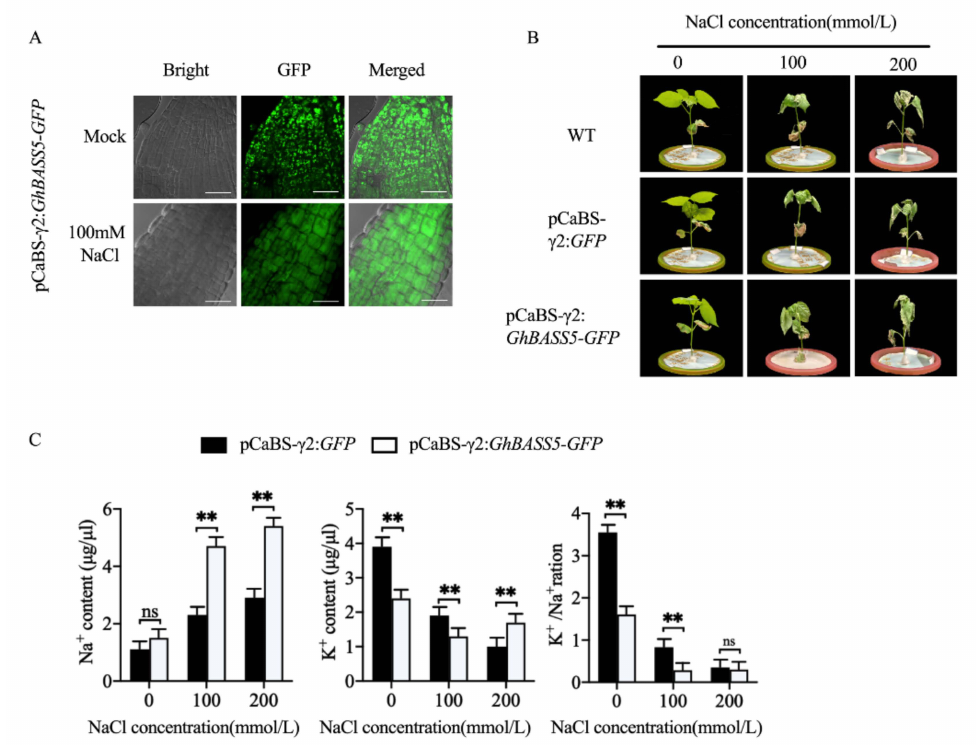
Figure 4. The characterization of GhBASS5 in the salt tolerance using the BSMV system. ( A ) Fluores- cence signal of GhBASS5-GFP in cotton root cells under simulated and salt stress; ( B ) phenotypes of the WT, GFP, and GhBASS5-GFP plants under simulated and salt stress; ( C ) Na + and K + contents in GFP plants and GhBASS5-GFP plants obtained via viral solution immersion under 100 mM salt treatment. The scale bar is 5 µ m. ** denotes a significant difference at p < 0.01 while ns indicates no significant difference, based on a two-tailed Student’s t